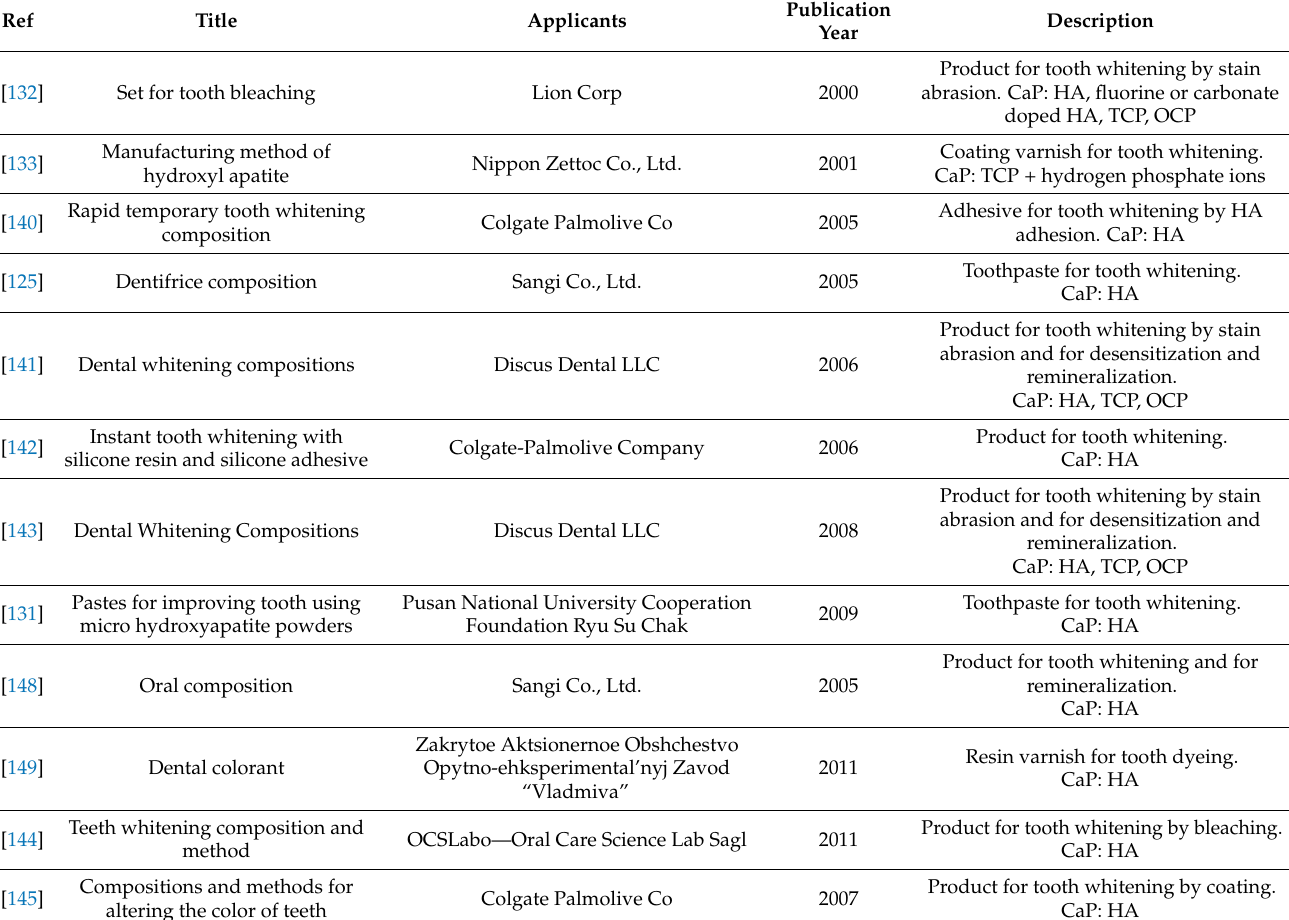
Table 1. List of patents about calcium phosphates in oral